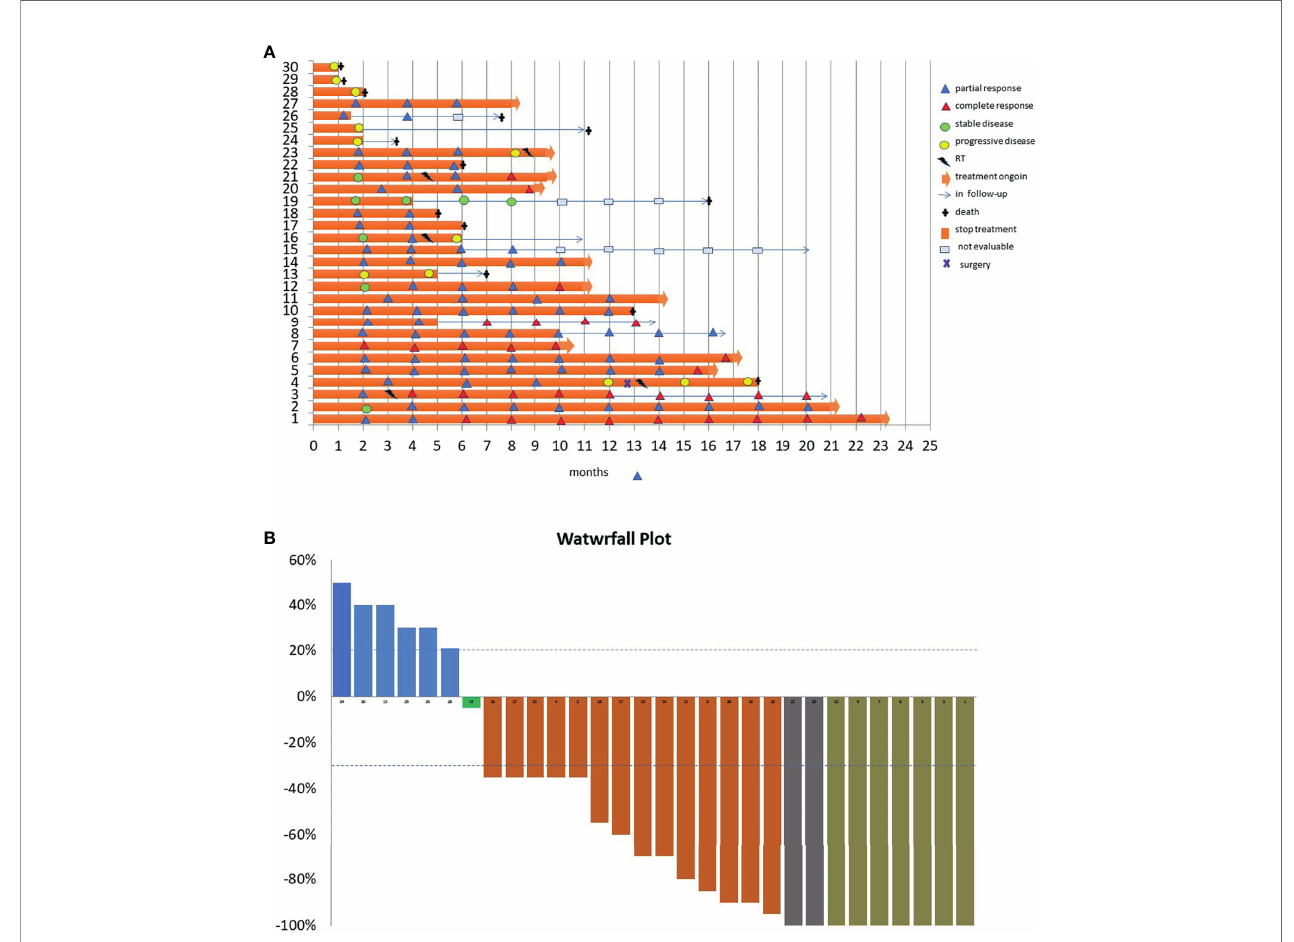
FIGURE 2 | (A) Swimming plot showing the time and duration of response (30 patients). Each horizontal line represents one patient. (B) Waterfall plot representing the rate of change in target cutaneous squamous cell carcinoma lesions from baseline during the cemiplimab (BMI ≥ 25 kg/m 2 ) vs . non-overweight (BMI <25 kg/m 2 ) patients (80 vs . 75%) ( Figure 3 ).